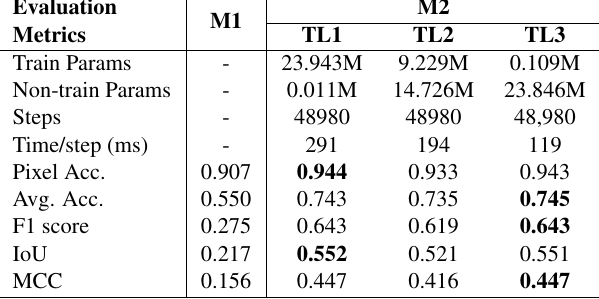
Table 2 . Cross-domain validation results on Melbourne Build- ing dataset (TR2). M1 refers to the base model trained on the WHU Building dataset (TR1) and validated on TR2. M2 refers to the model previously trained on TR1 and fine-tuned on TR2 with three fine-tuning strategies (TL1, TL2, and TL3).